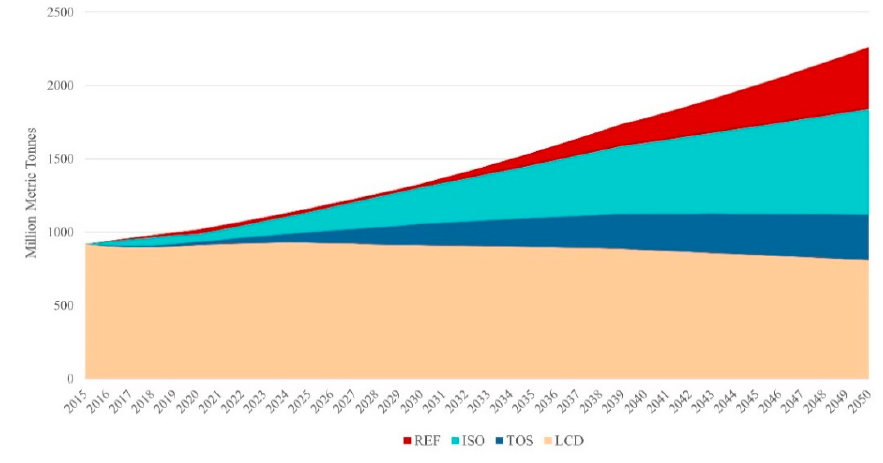
Figure 7. The trend of CO 2 emission in 2015-2050 in the four scenarios.